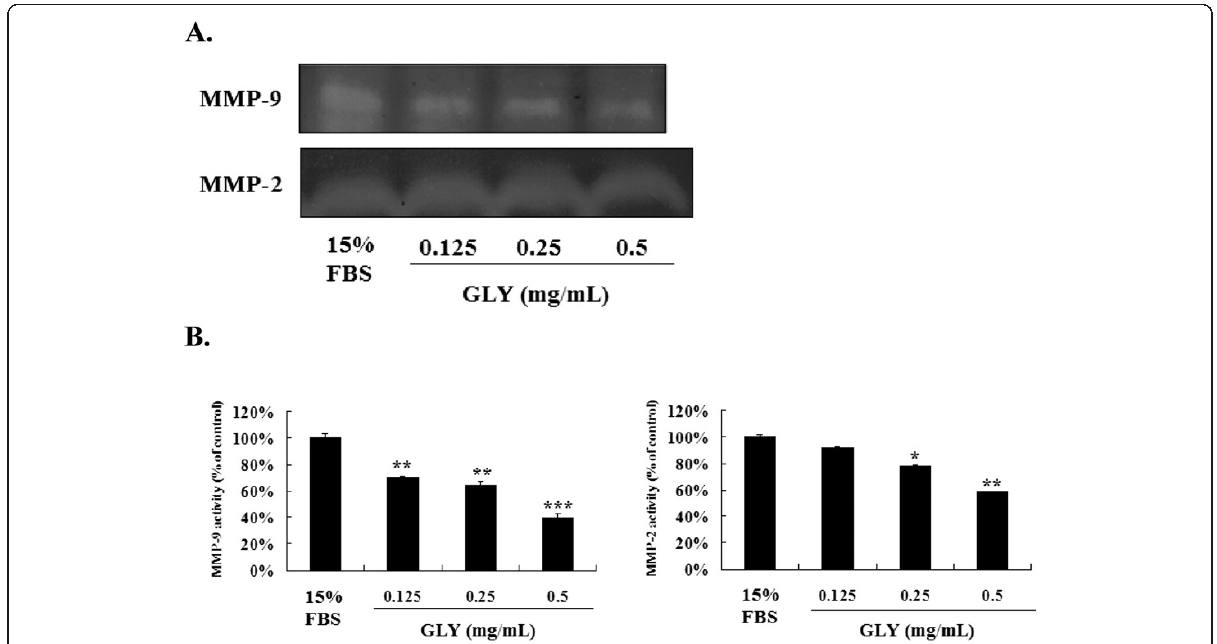
Figure 3 GLY inhibits the release of MMP-2 and MMP-9 in VSMCs. ( A ). To examine the possible antimigration mechanisms of GLY, we determined the activity of MMP-2 and MMP-9 in culture media of VSMCs cells by zymographic analysis. ( B ). GLY inhibited MMP-9 and MMP-2 activities in a concentration-dependent manner. Values are means of three separate experiments, with standard errors represented by vertical bars. Mean value was significantly different from that of the control group :* p <0.05,** p <0.01, *** p